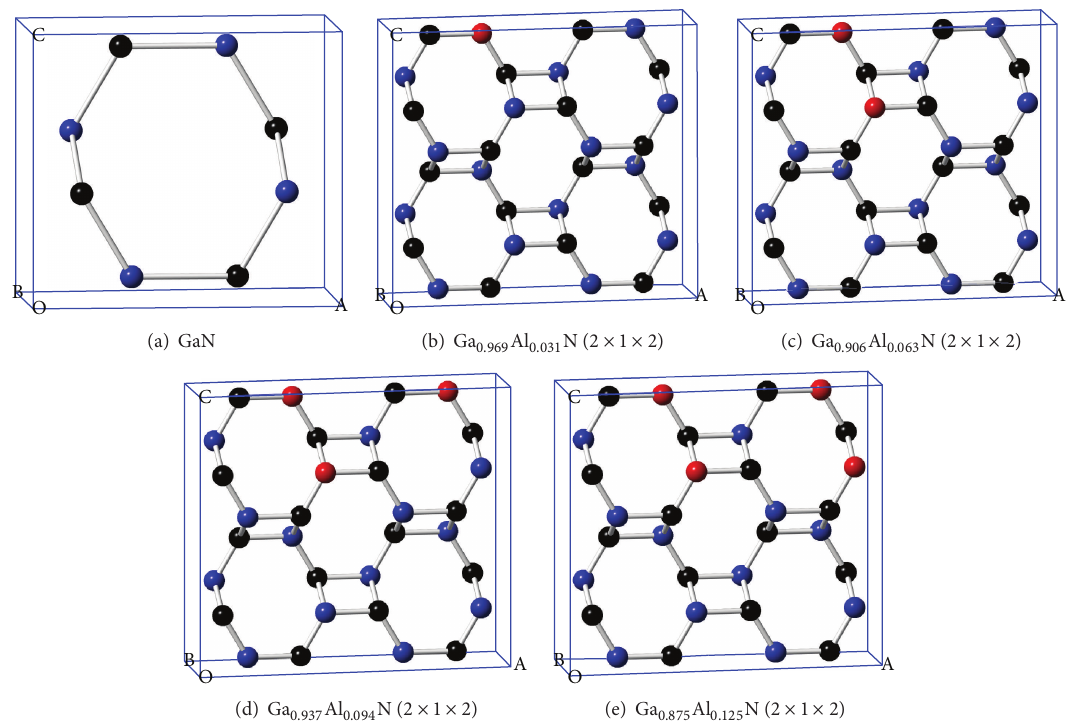
Figure 1: Crystal structures of (a) Pnma-GaN, (b) Ga 0.969 Al 0.031 N, (c) Ga 0.937 Al 0.063 N, (d) Ga 0.906 Al 0.094 N, and (e) Ga 0.875 Al 0.125 N; the red, blue, and black spheres represent Al, Ga, and N atoms,